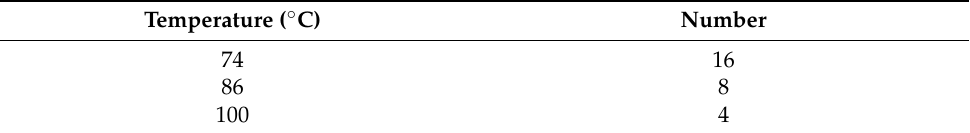
Table 3. Accelerated life test